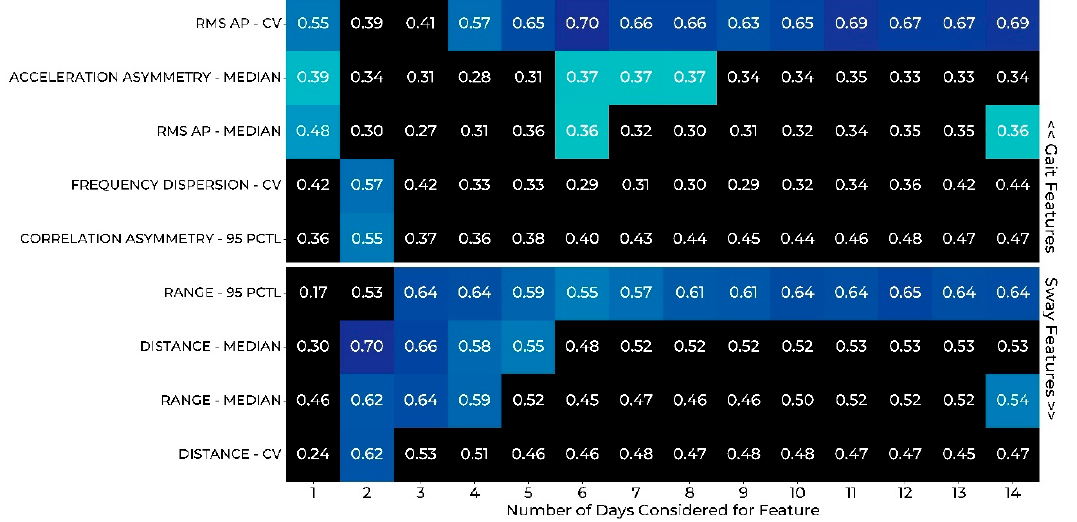
Figure 3. Spearman correlation between Modified Fatigue Impact Scale (MFIS) and measures of gait and postural sway by number of sensor-wear days. Cells shaded in blue represent significant correlations (more green = weaker, more blue = stronger) and cells shaded in black were not significant. PCTL: Percentile; CV: Coefficient of variation; RMS: Root mean square; AP: Anterior-posterior; ML: Medial-lateral. Table 2. Wear duration time regression